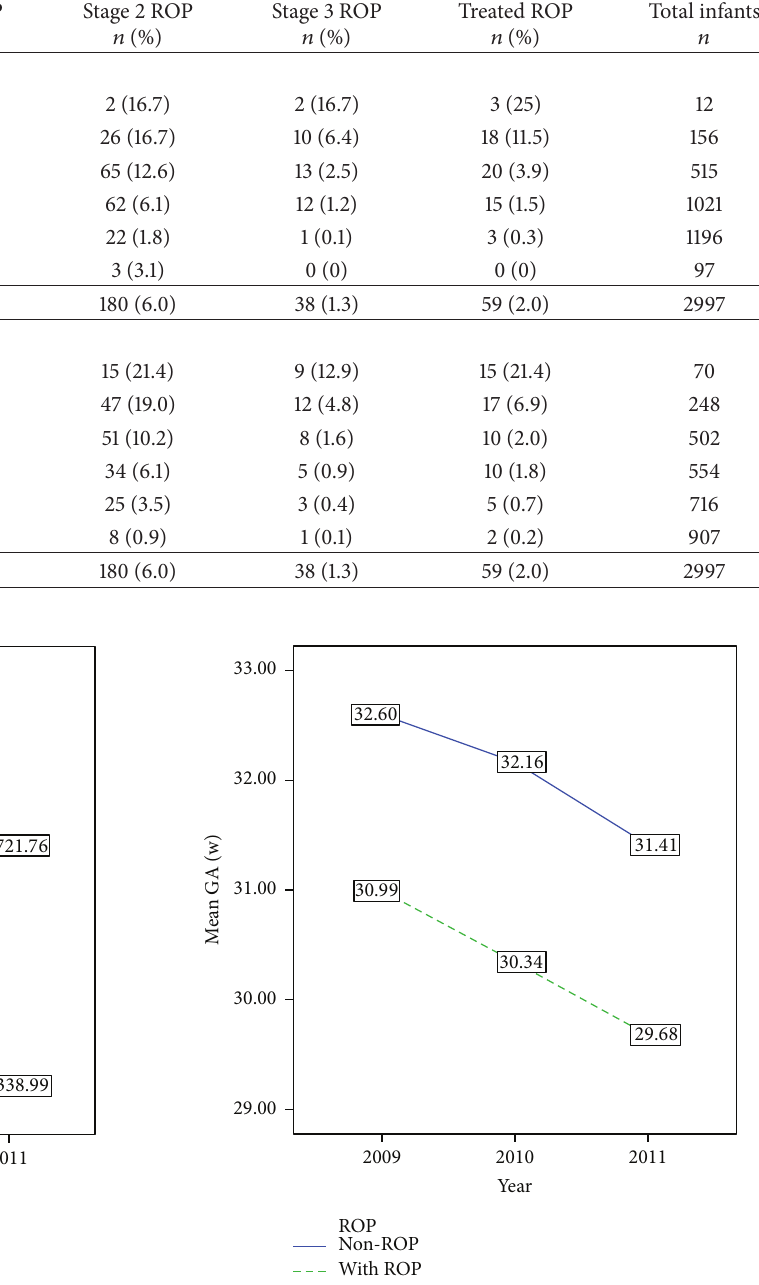
Table 2: The incidence rate of ROP with different stages according to gestational age and birth weight.